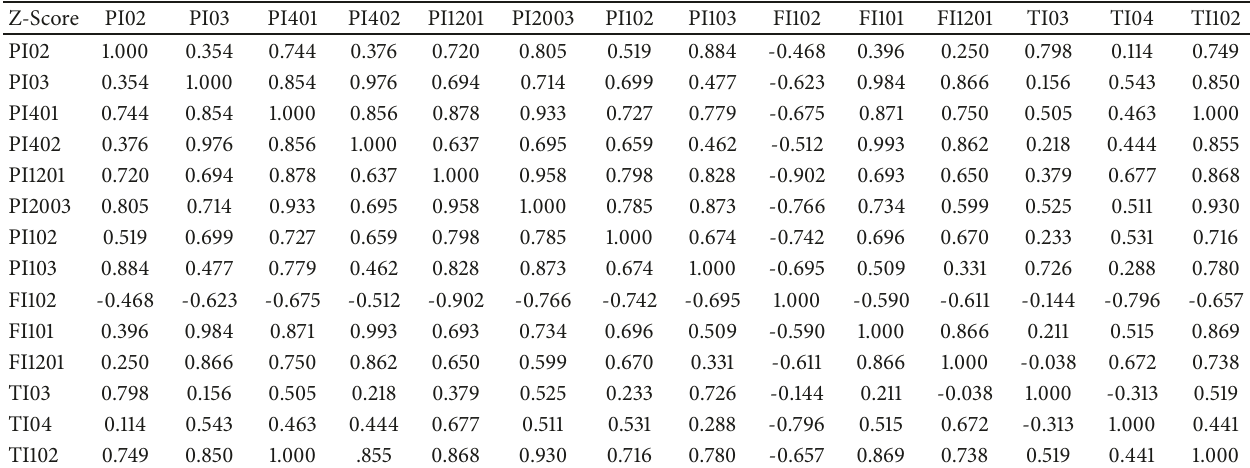
Table 4: Correlation coefficient matrix.